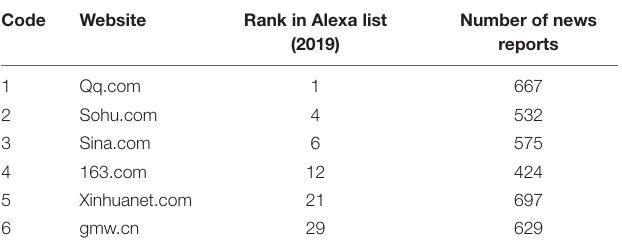
TABLE 1 | Six portals in the news search area and the number of news selected. Code